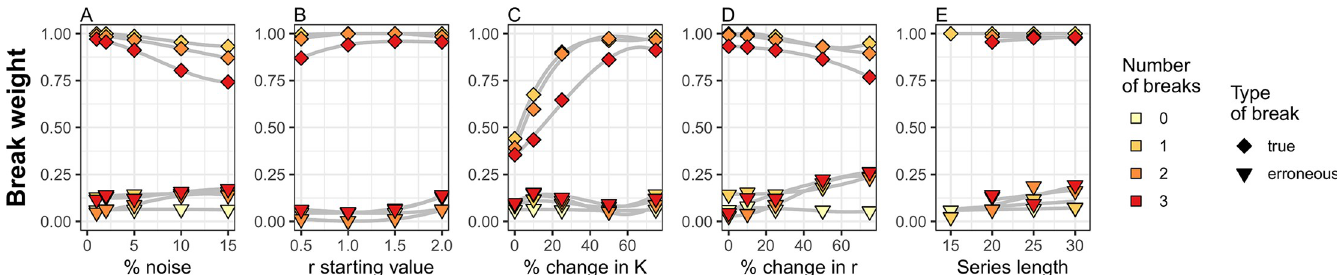
Fig 2. Average break weight of break points detected under varying parameterization conditions. Average weights of break points identified by the Dynamic Shift Detector algorithm reflecting true parameterization conditions (diamonds) or erroneous breaks suggested by the algorithm (triangles) under varied A) noise (in the form of normally distributed error), B) starting values of the r parameter, C) percent changes in the K parameter, D) percent changes in r , and E) simulated time series length. Sets of 0, 1, 2 and 3 break points were randomly generated from within the set of possible values, and 250 datasets were simulated for each scenario. In each panel, other variables (that were not being varied) were held constant at their base values (i.e., noise = 2%; starting value of r = 2; change in r = ± 25%; change in K = ± 75%; time series length = 20 years). Trends within a set of scenarios (grey lines) are illustrated with a third-order GAM smoothing